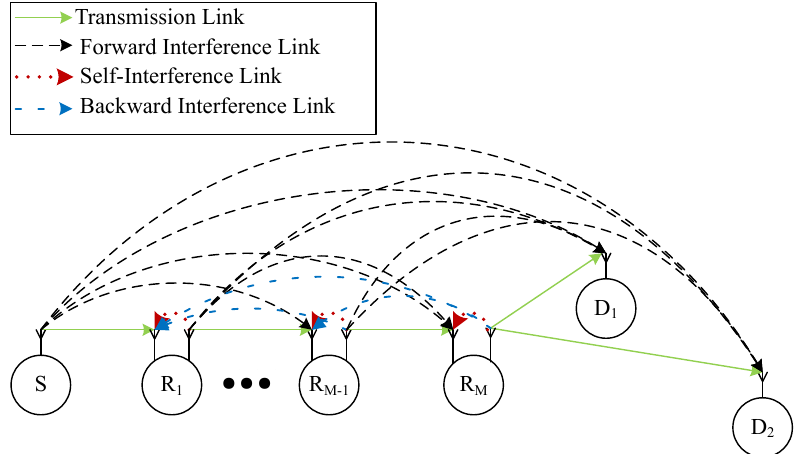
Figure 1. The considered multi-hop FD NOMA